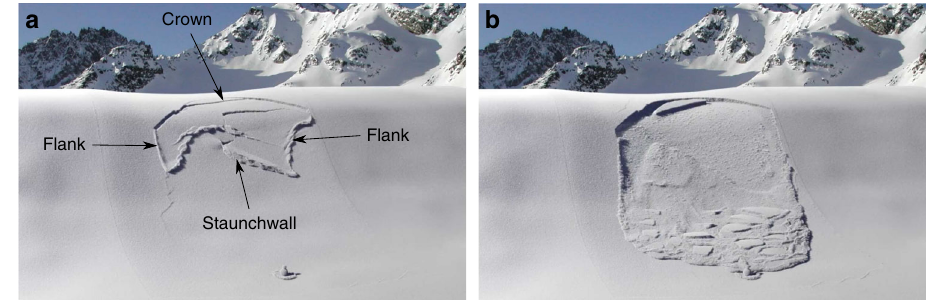
Fig. 3 3D slope-scale simulation of remote avalanche triggering (Supplementary Movie 7). a Release zone showing an arc crown line as well as jagged fl anks and staunchwall. b Flow of the